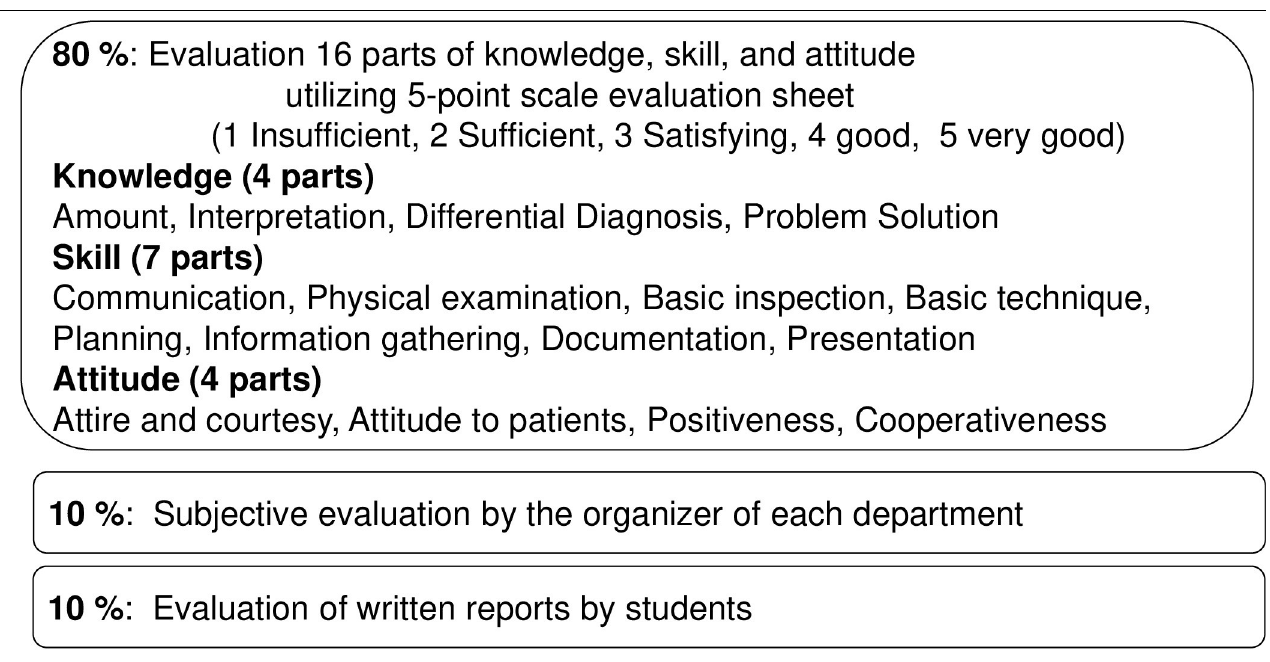
Fig 2. Contents of clinical clerkships (CC) evaluation in our college. Accomplishment consists of 5-point evaluation sheet for 16 parts (80%), subjective evaluation by the organizer (10%), and written report (10%).